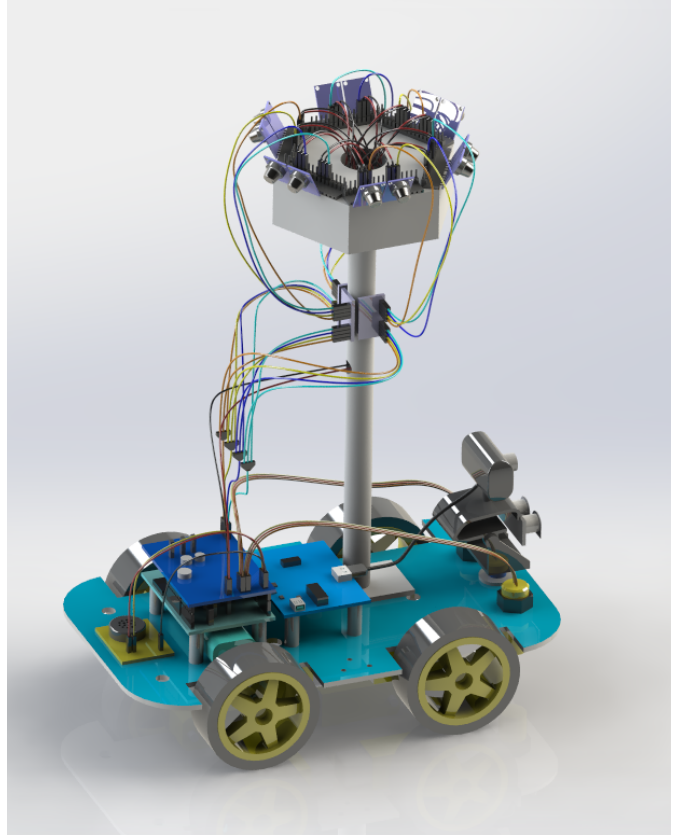
Figure 2. Model of multiple hazard gas detector